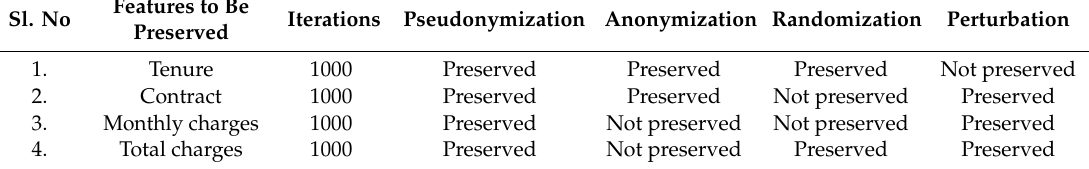
Table 5. Comparison of privacy preservation by pseudonymization and other PPDM models.